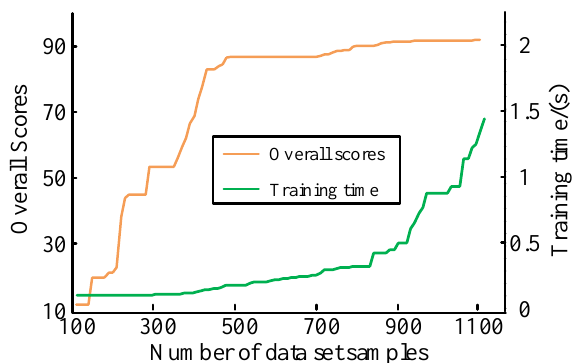
Figure A1. Curve of overall score in different numbers of input samples.